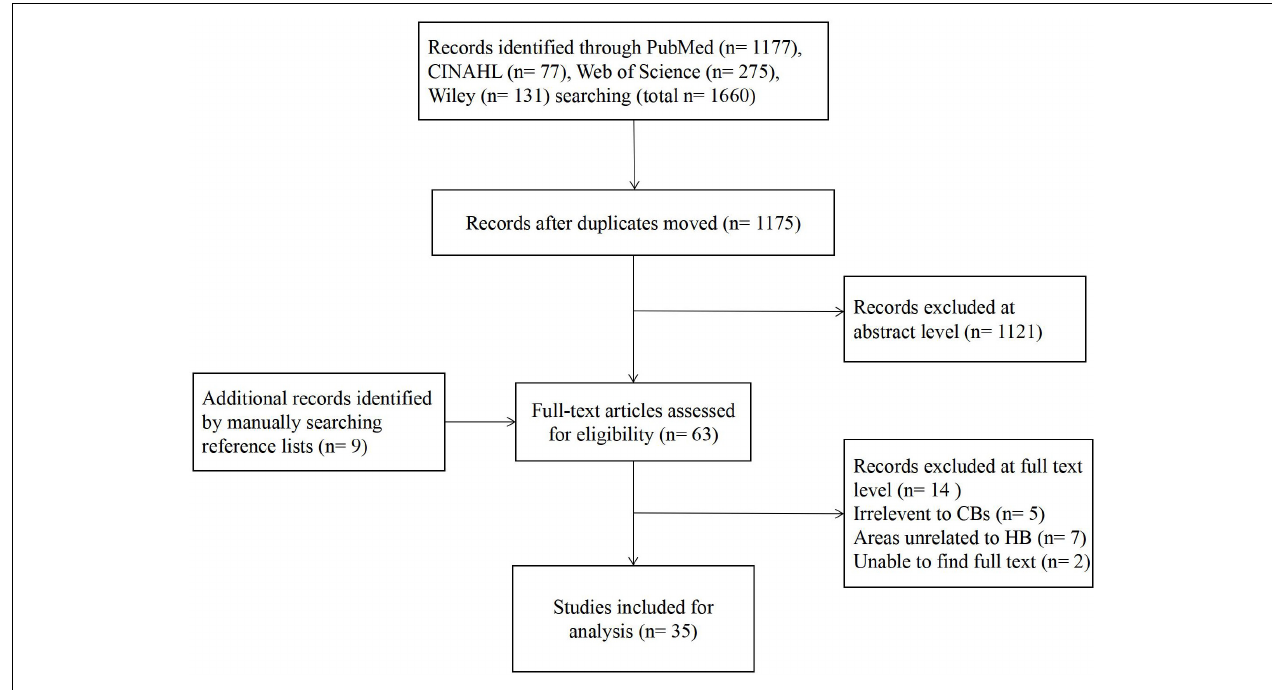
FIGURE 1 | Flowchart of the study selection process of the concept